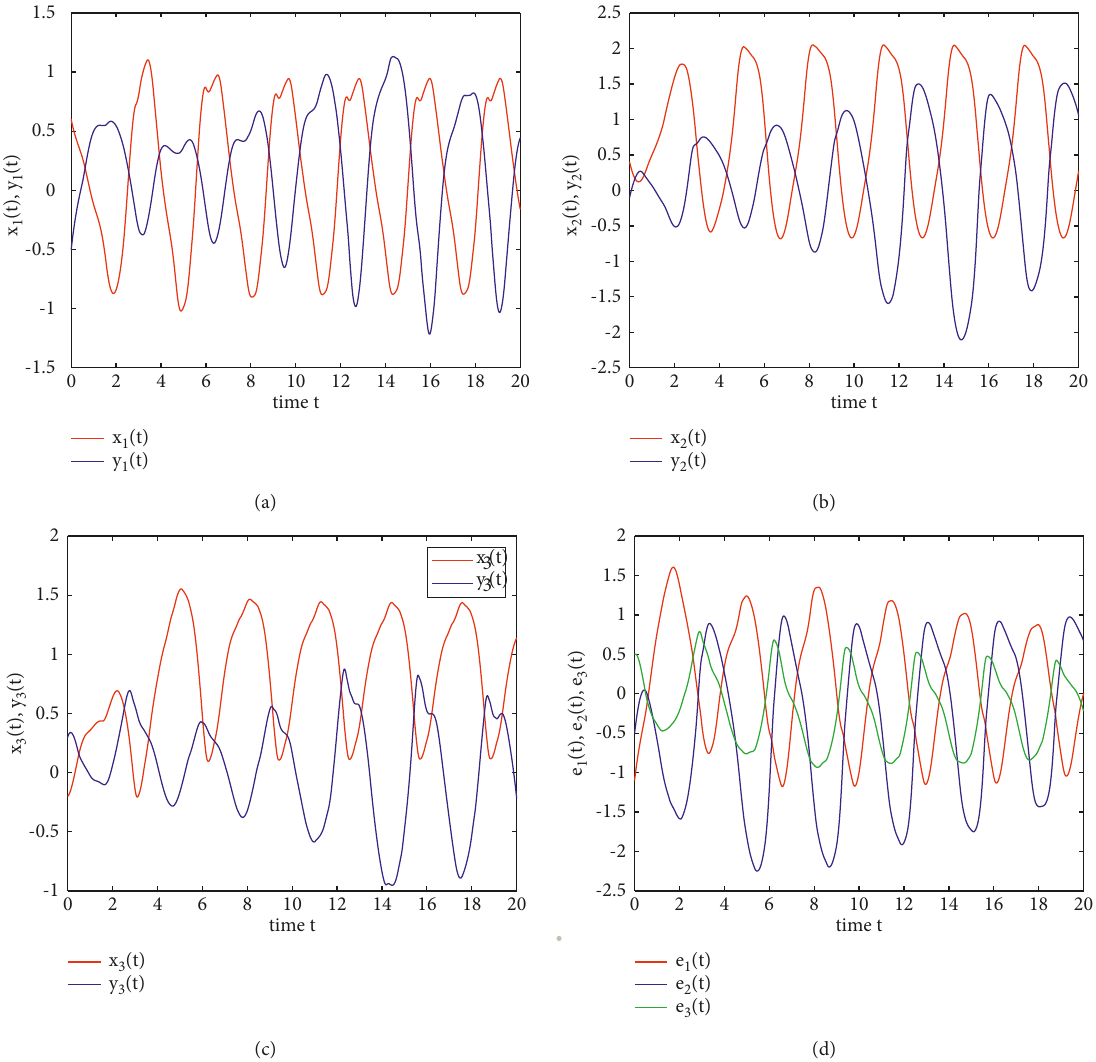
( t ) and y ( t ) for drive- 2 2